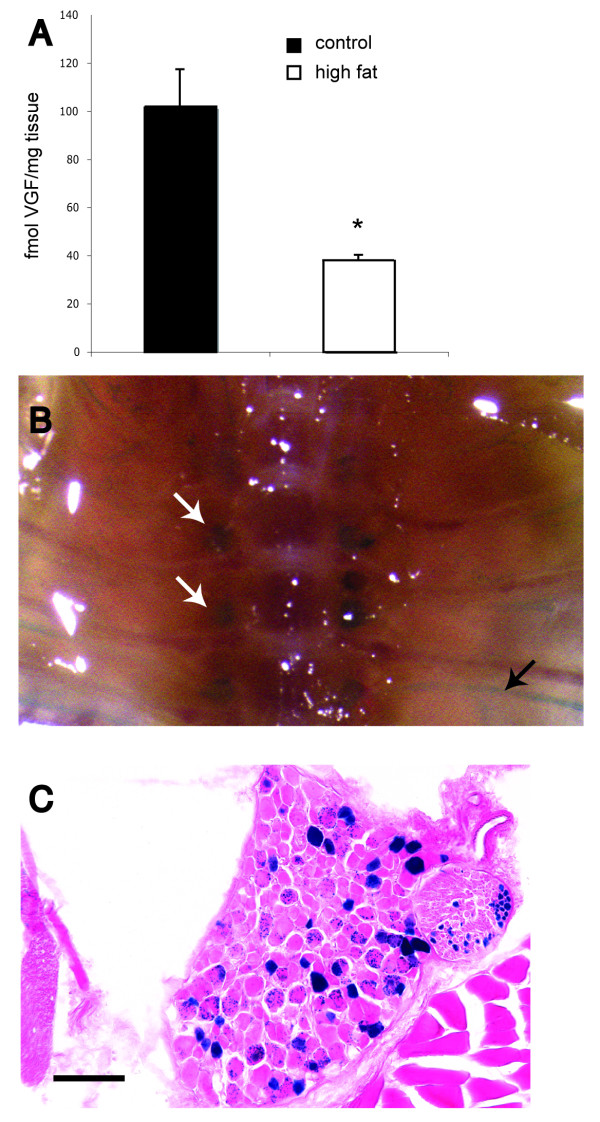
VGF is expressed in neural pathways that innervate brown adipose tissue (BAT). In panel A, levels of VGF-derived peptides were quantified in BAT from C57Bl6 female mice fed standard chow or a high fat, high carbohydrate diet for 14 days. BAT was removed and RIA analysis carried out to quantify C-terminal VGF-derived peptides (NAPP129, TLQP62 and AQEE30, but not full length VGF), using polyclonal anti-AQEE30 (VGF588-617) antiserum as previously described [38]. VGF peptide levels in BAT were significantly reduced in mice fed the high-energy diet in comparison to control mice (p < 0.05). Comparisons by ANOVA [mean ± SEM; high fat diet (n = 4), standard diet (n = 3)]. In panels B-C, Vgf gene expression was visualized in neural pathways that innervate tissues including BAT using a lacZ reporter gene that was knocked into the mouse Vgf locus in VGFR mice (see Methods). In panel B, β-galactosidase expression (blue staining) in the dorsal root ganglia (white arrows) and intercostal nerve (black arrow) is seen in a whole mount preparation from a heterozygous VgfR +/- mouse. A dorsal root ganglion section is shown at higher magnification in panel C (scale bar is 100 μm in length).